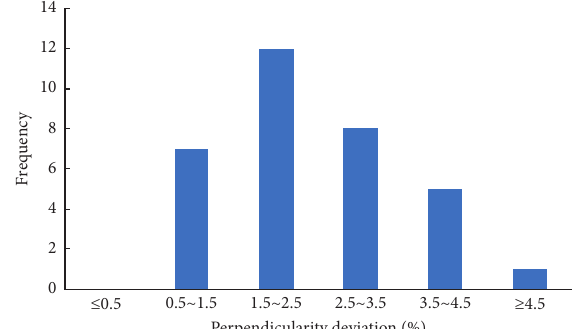
Figure 7: Sectional statistics of vertical deviation of pipe pile.